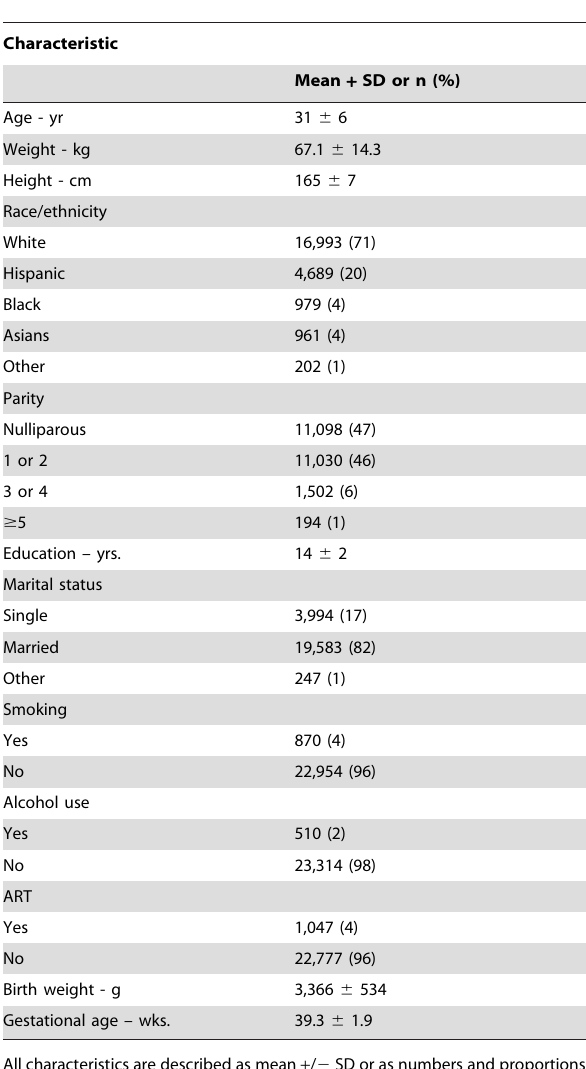
Table 3. Baseline Characteristics of the FASTER trial